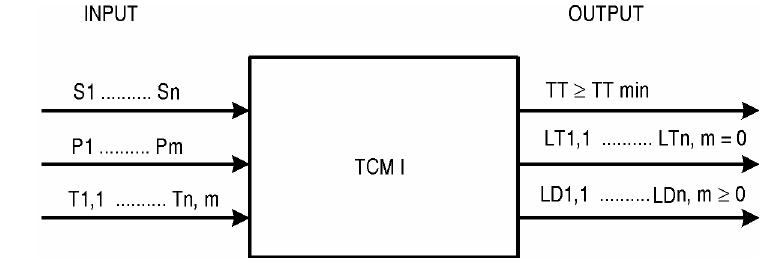
Fig 2. Computational scheme for condition I